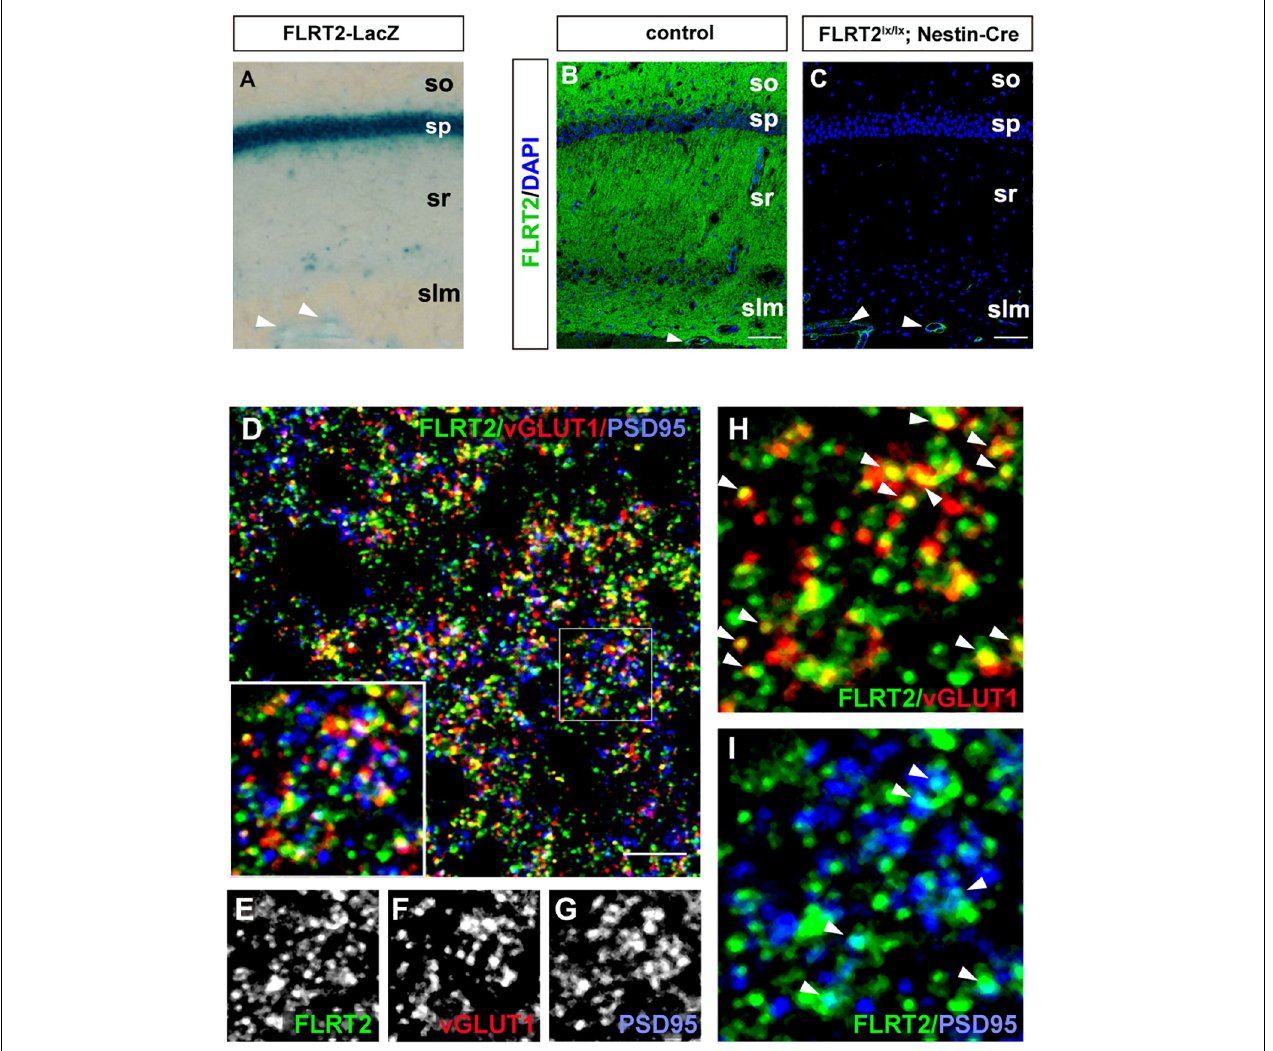
FIGURE 5 | Synaptic localization of FLRT2 in the CA1 of adult mice. (A) FLRT2- LacZ expression was strong in the pyramidal layer. (B) FLRT2 protein expression was distributed in the layers of so, sr, and slm but not in sp. (C) FLRT2 was specifically knocked out in CA1 neurons in conditional knockout mice, but not in blood vessels (arrowheads). (D–I) FLRT2 partly colocalized with vGLUT1 and PSD95 (arrowheads in H and I ). Inset: higher magnification. so, stratum oriens; sp, stratum pyramidale; sr, stratum radiatum; slm, stratum lacunosum-moleculare. Scale bars, 100 µ m (B,C) , 5 µ m (D) . n = 4 for Flrt2-LacZ KI adulthood